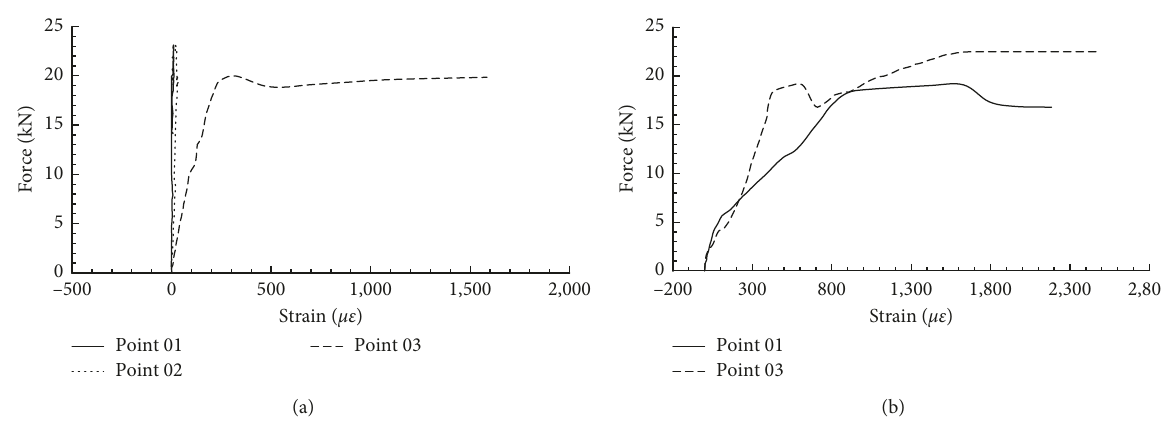
Figure 8: Strain at different locations of beam bottom. (a) Fully bonded. (b) Unbonded.